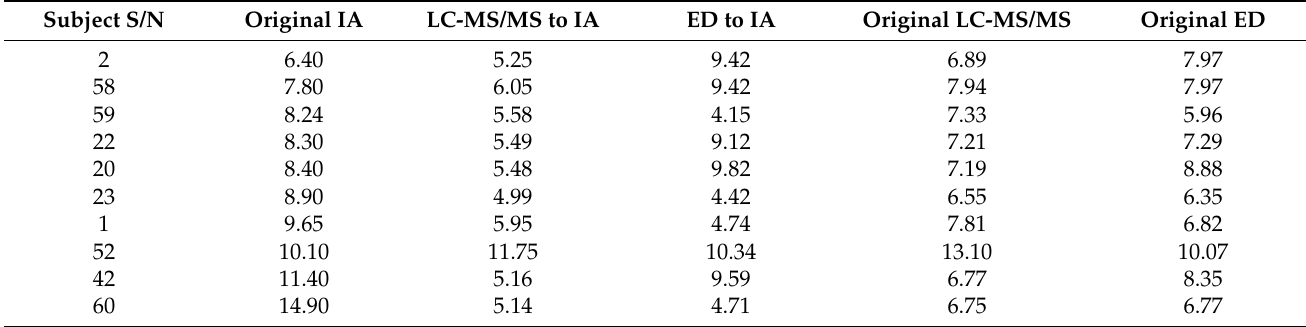
Table 9. An example of FT4 values (pg/mL) measured by IA and transformations in LC-MS/MS and ED scales using linear transformation. Table 10. An example of FT4 values (pg/mL) measured by IA and their transformations in LC-MS/MS and ED scales using piecewise linear